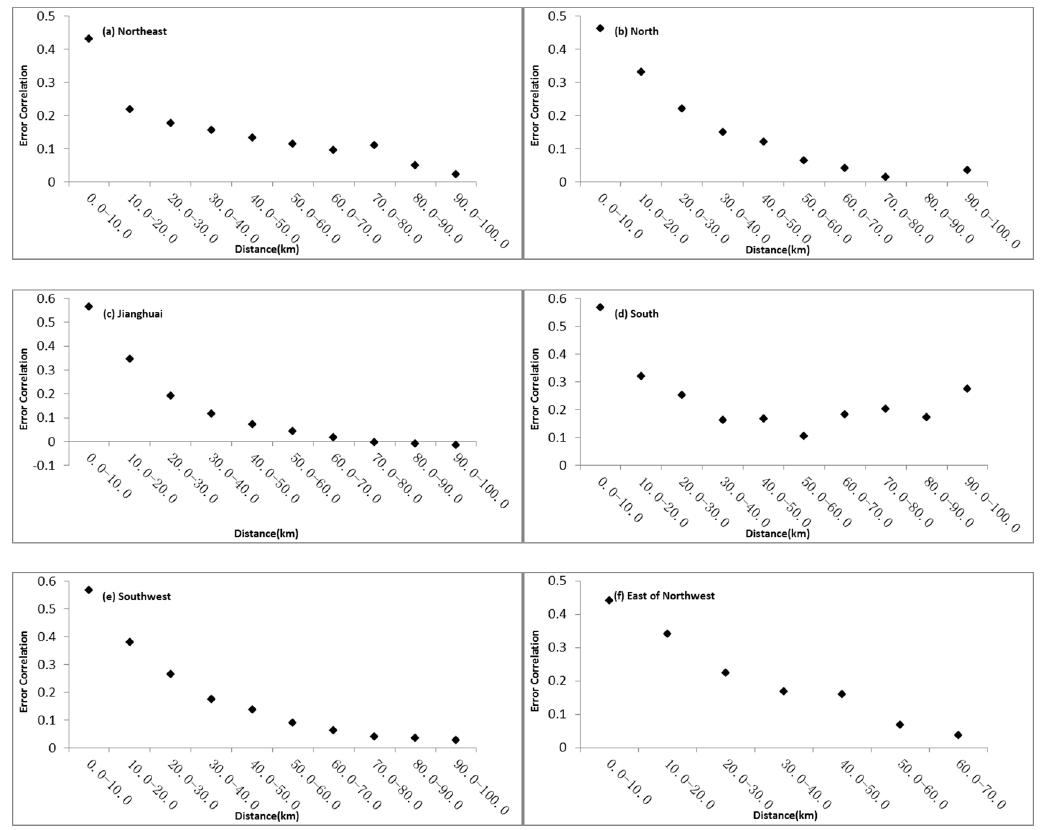
Figure 8. Same as Figure 7, but for the error correlation coefficient of the radar QPE with the distance between any two points.